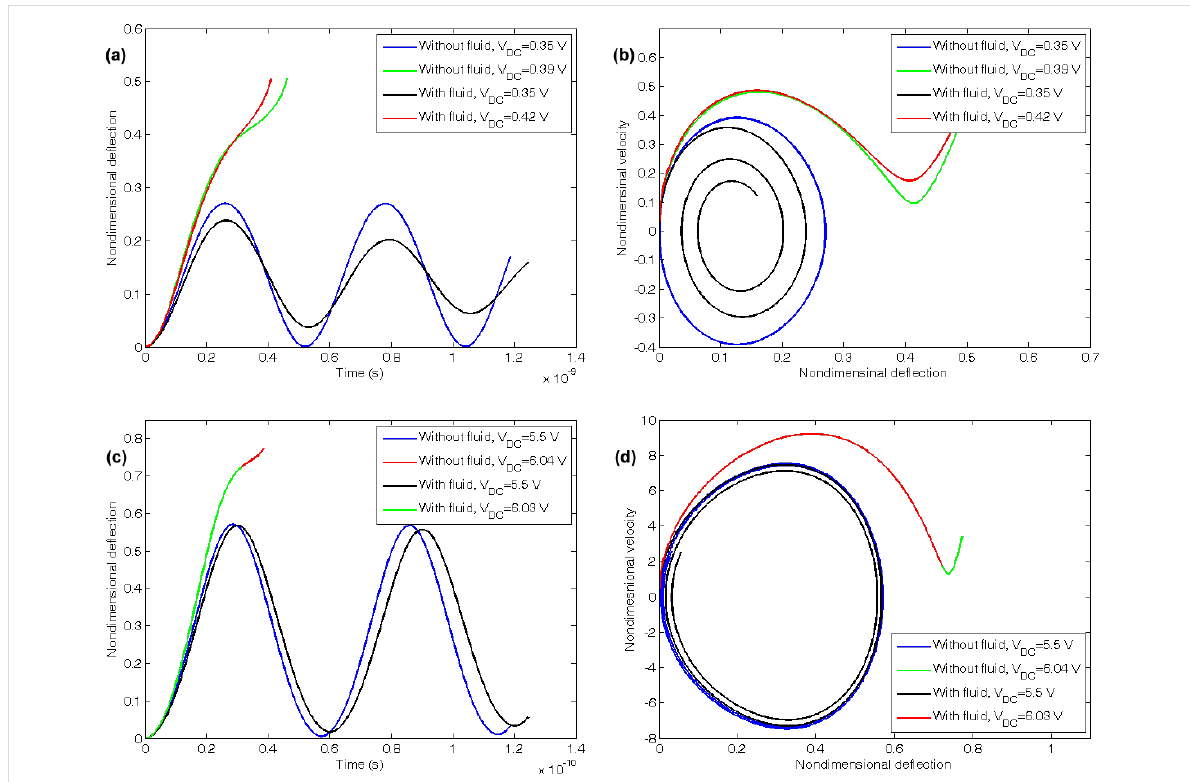
Figure 5: Vibration and phase plane of the (a), (b) cantilever, (c), (d) doubly clamped CNTs under step DC voltage.